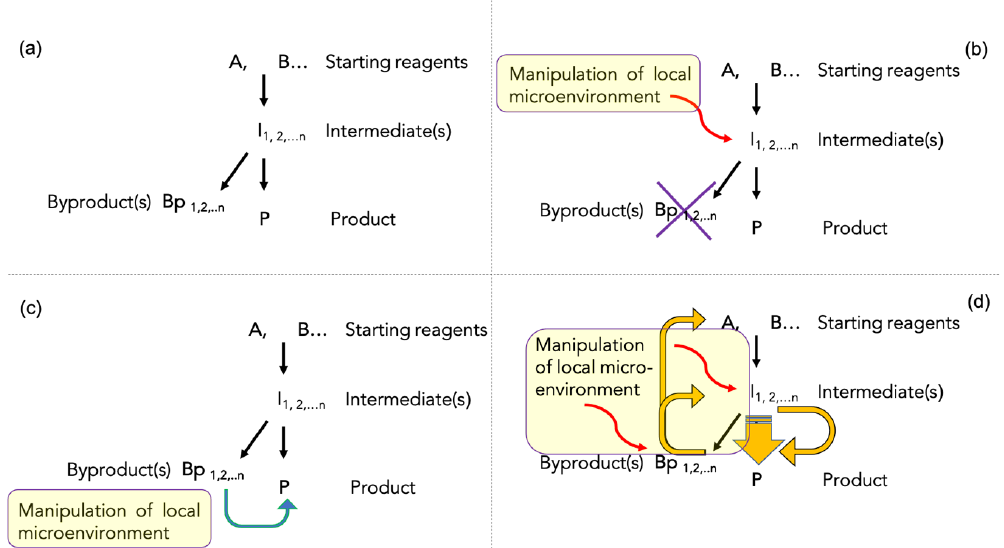
Figure 2. Schemes of different catalytic strategies utilized to promote selectivity and yield of a given process: ( a , b ) systemic approach based on the manipulation of catalyst’s local environment for the limitation of byproducts formation; ( c ) systemic approach based on the manipulation of local environment for the smart conversion of undesired byproducts into targeted products; ( d ) systemic approach based on design of chemical loops that take advantage of the manipulation of the local environment at different stages of the process and might leverage on concurrent reactions.